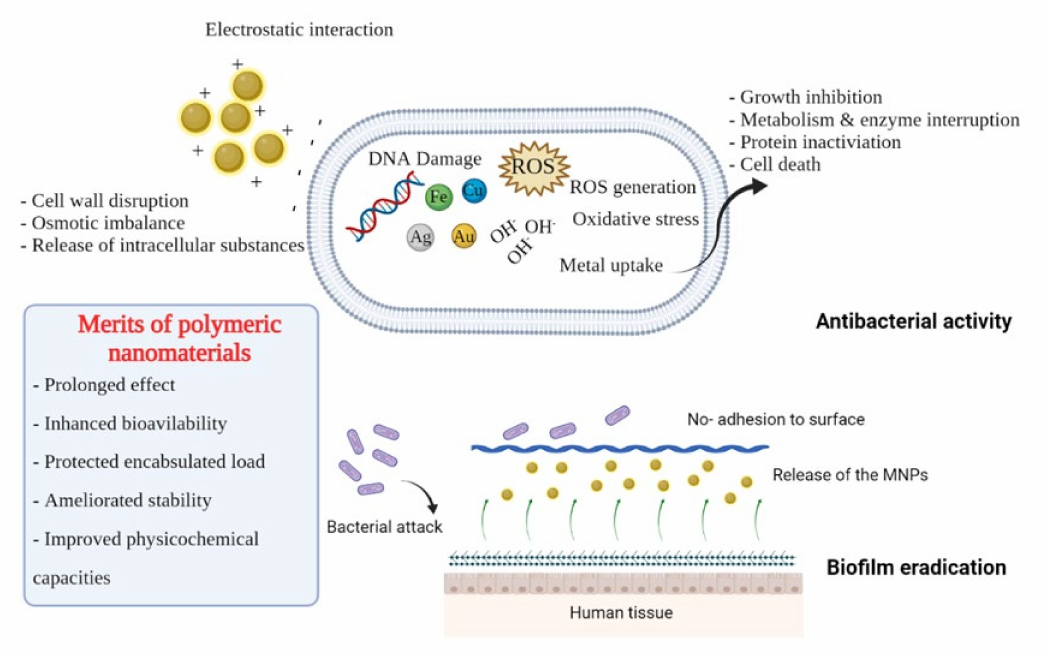
Figure 4. Schematic diagram of antibacterial and antibiofilm mechanisms of biobased polymeric